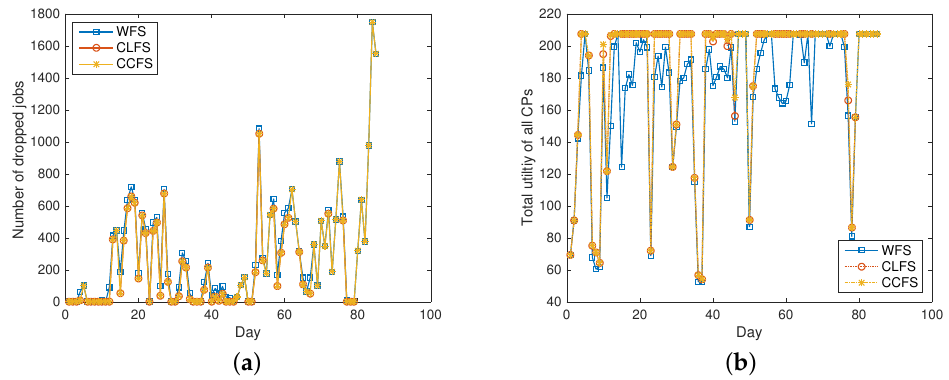
Figure 2. Two-player scenario ( c = 20, k = 1, γ 1 = γ 2 = 1.25). ( a ) The number of dropped jobs under the three solutions; ( b ) the utility under the three